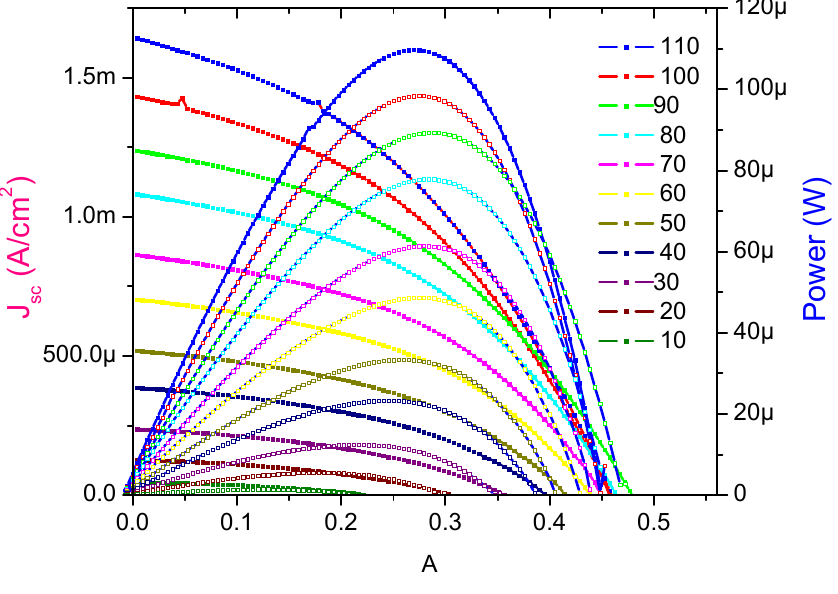
Figure 6. J–V and P–V characterization of HTS based QDSSC at different intensities of